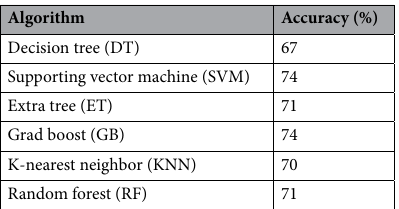
Table 6. Machine learning results with 6 ISI/ESS items.